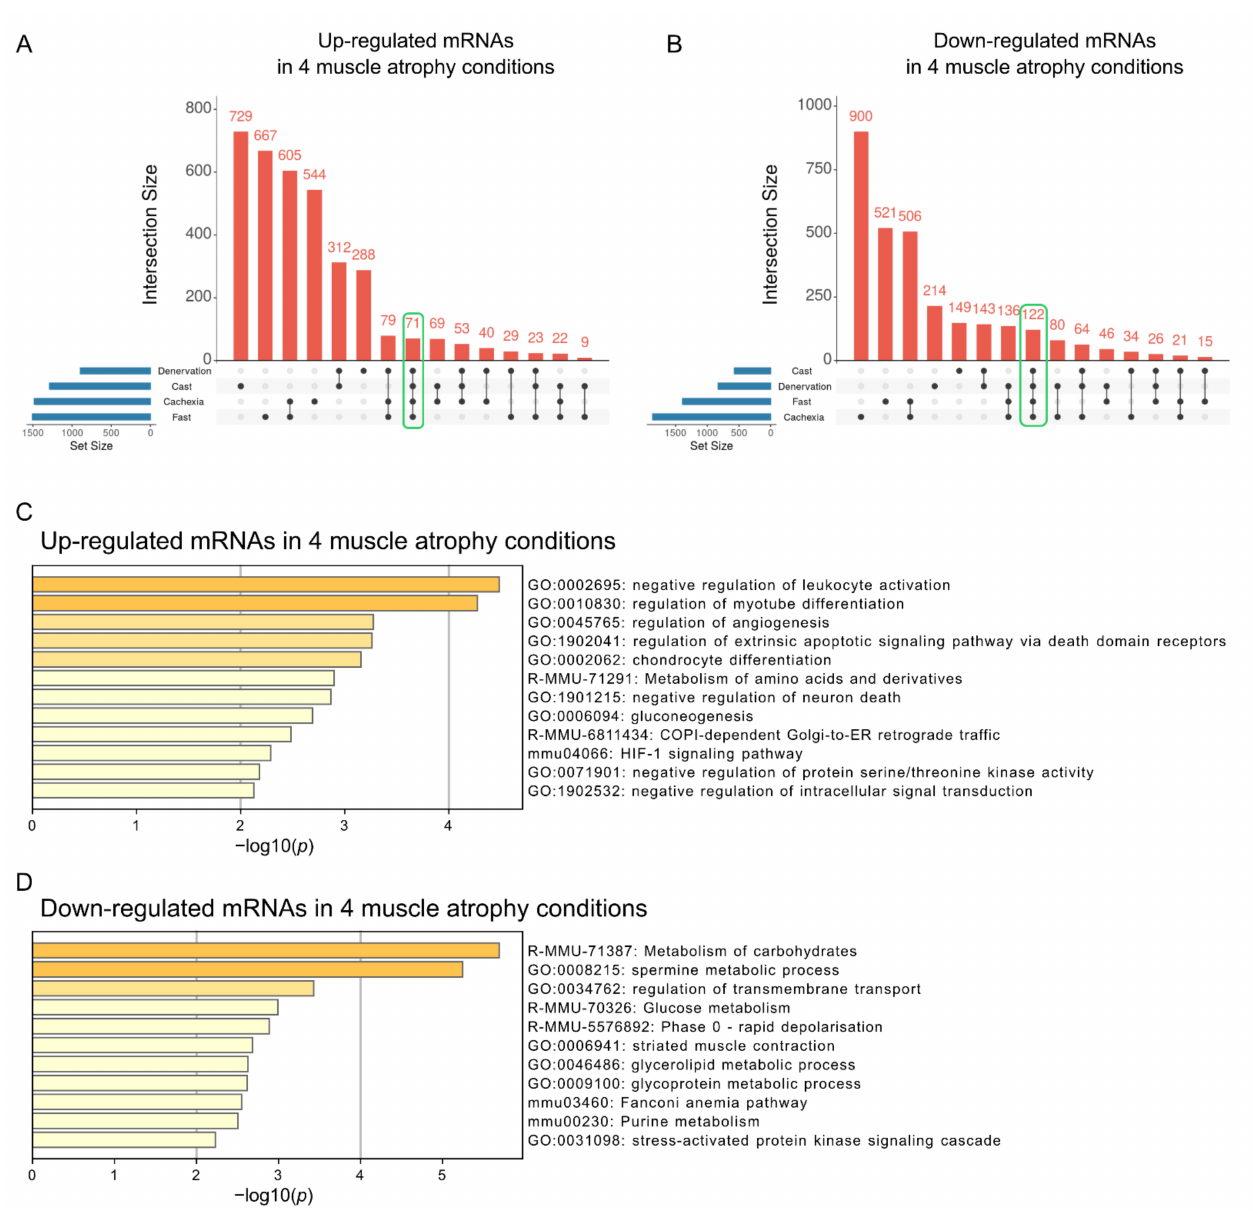
Figure 4. Functional enrichment analysis of mRNAs with altered expression across all four muscle atrophy conditions. The UpSet plot shows the intersections of up- ( A ) or down-regulated ( B ) mRNAs among four muscle atrophy conditions. Each column corresponds to an exclusive intersection containing the elements of the set indicated by the black circles but not the elements of any other set. Set sizes related to blue horizontal bars represent the total number of differentially expressed mRNAs for each condition. The intersection sizes between different muscle atrophy conditions represent exclusive intersections (i.e., intersection sets that are not a subset of other intersection sets). The number of mRNAs whose expression was commonly altered in all four muscle atrophy conditions is encircled by the green line. The results of functional enrichment analyses of up- ( C ) or down-regulated ( D ) mRNAs common to the four muscle atrophy conditions are shown by a bar graph generated using Metascape. The x -axis represents the − log10 ( p